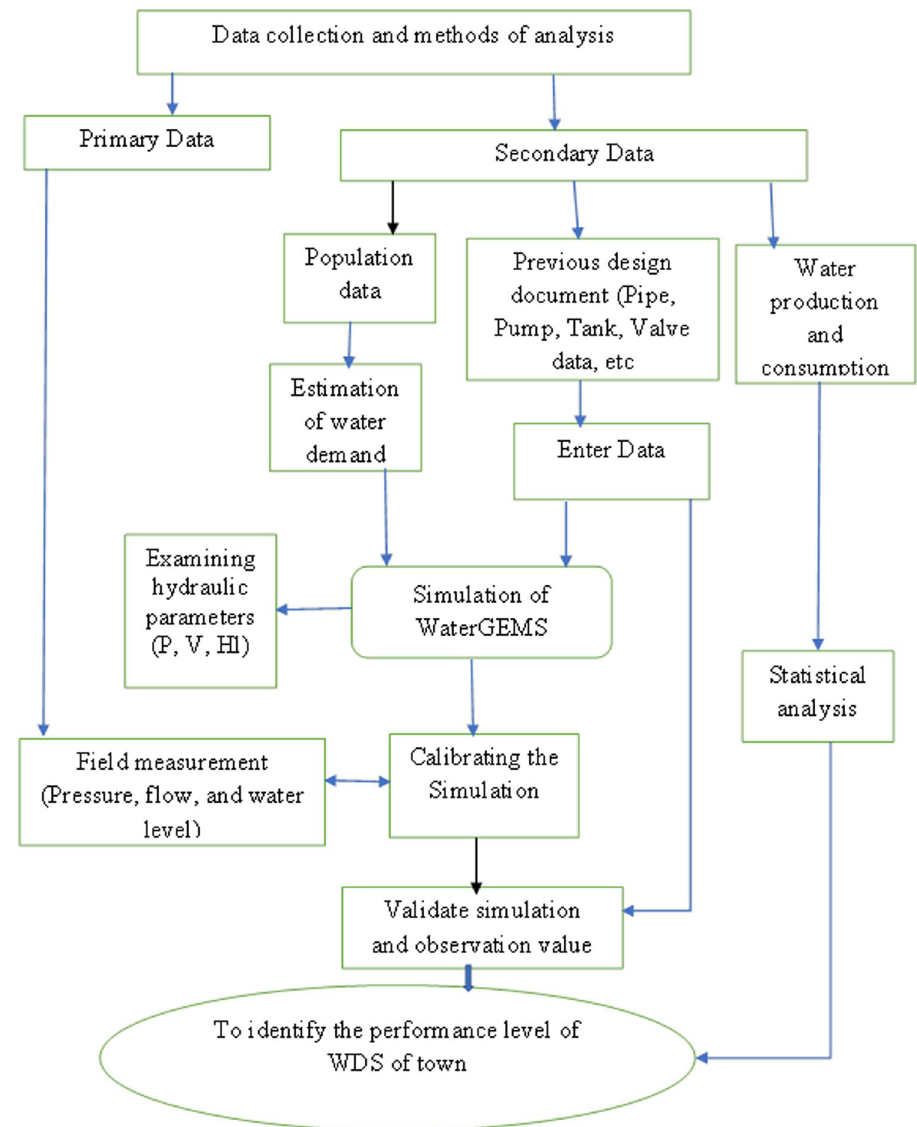
Fig. 2 Flowcharts of data col- lection and methods of data